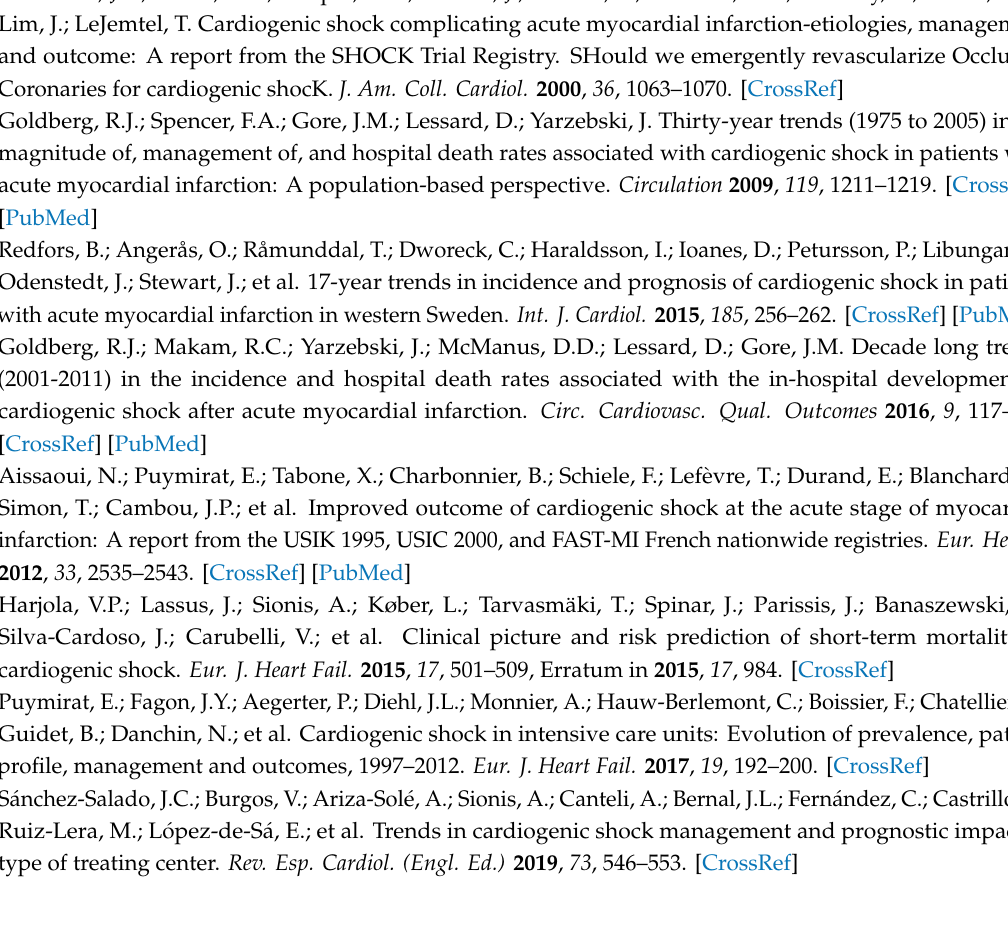
Table S1: In-hospital